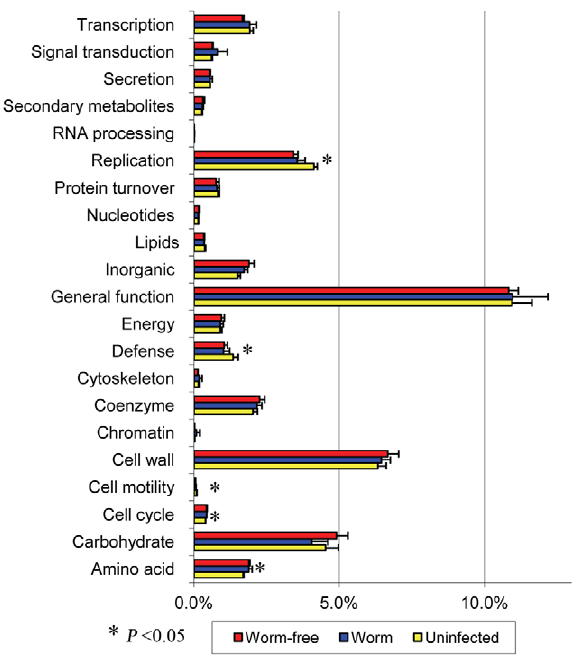
Figure 5. Functional categories affected by Trichuris suis infection in the porcine proximal colon microbiota annotated using the eggNOG database. The class labeled ‘‘unknown’’, which accounted for 61.34% of hits, were not included. * denotes significantly impacted by infection, regardless of the worm burden.